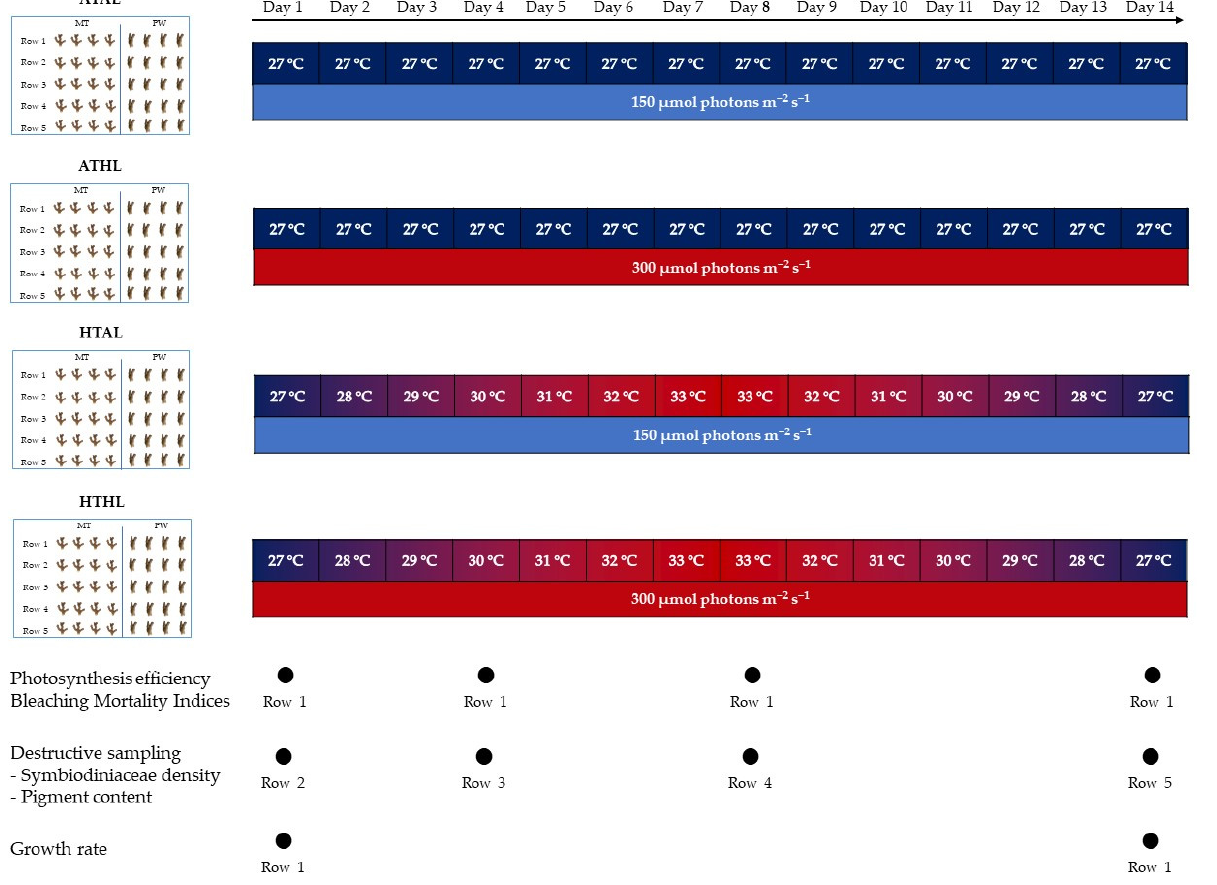
Figure 2. Experimental design applied to the coral nubbins from MT and PW in each treatment tank. The nubbins in Row 1 were used for non-destructive measurements of photosynthetic efficiency, Bleaching Mortality Indices, and growth rate, whereas the nubbins in Rows 2–5 were used for destructive sampling of Symbiodiniaceae density and pigment at Days 1, 4, 8, and 14, respectively. The destructive coral samples were removed from experimental tanks on the day previously described.